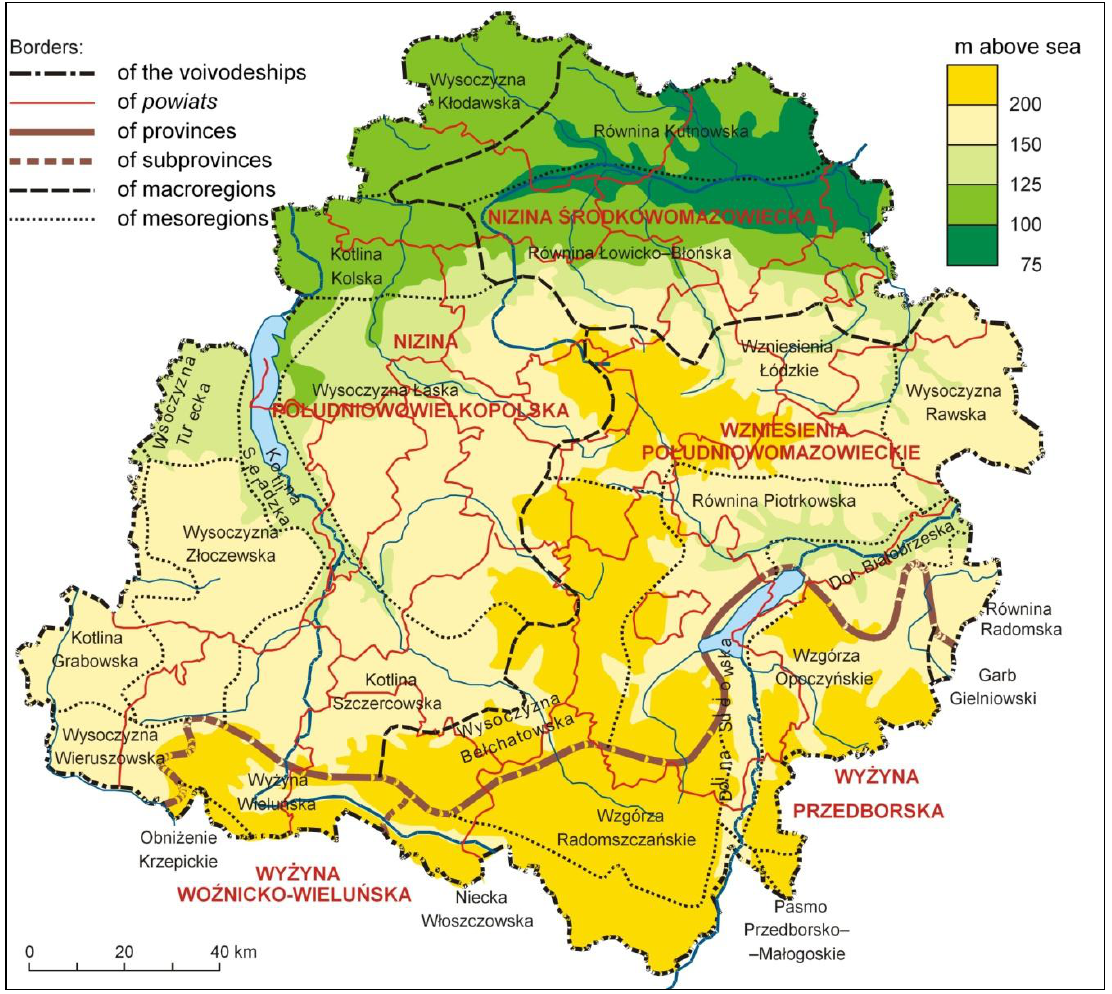
Fig. 2. The surface structure and the physical and geographical division in the Łódź voivodeship (according to Kondracki,